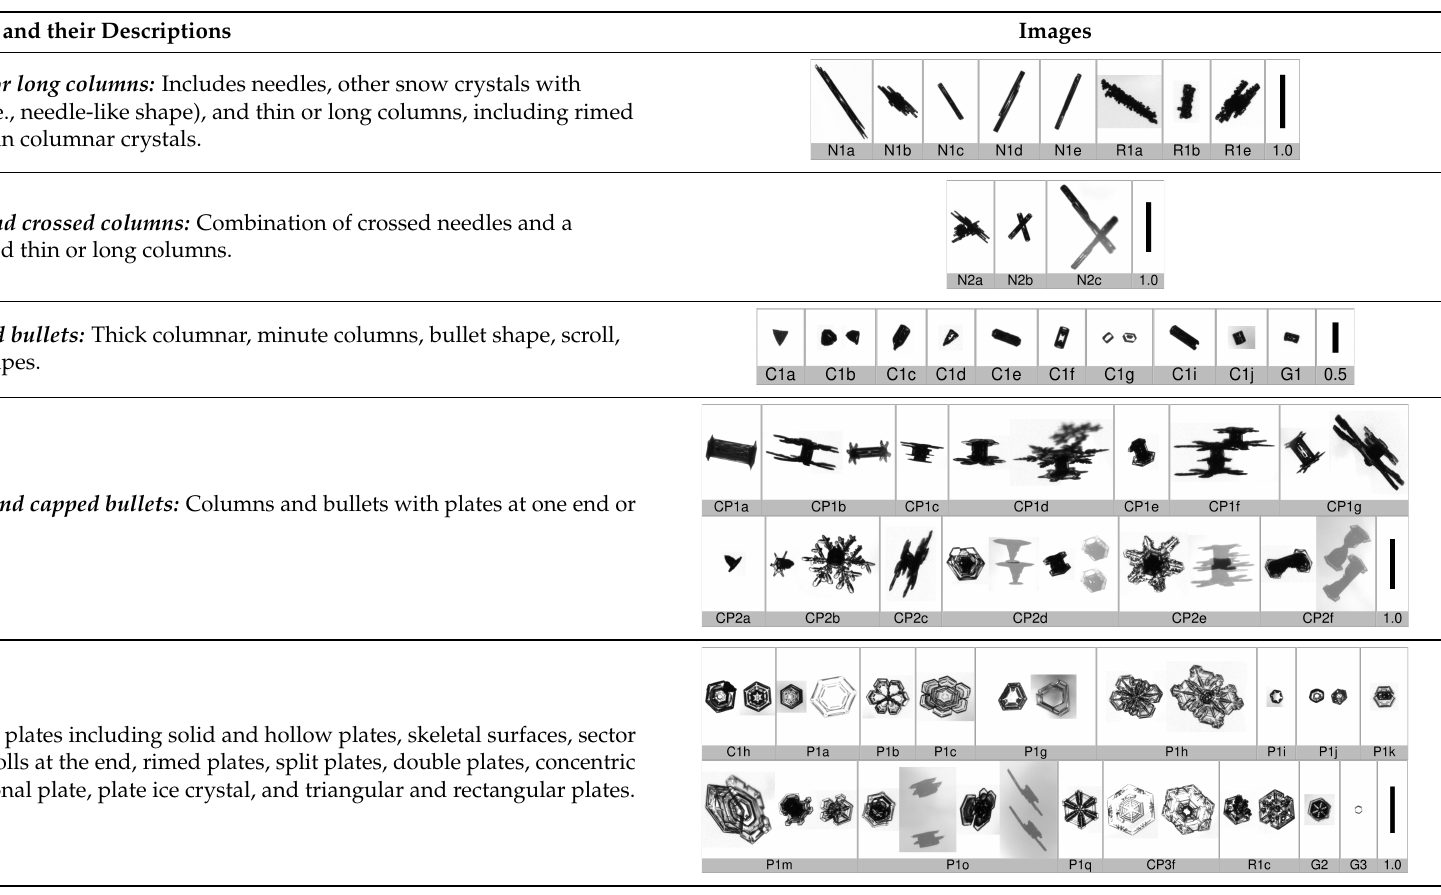
Table 4. Shape groups and their descriptions (part 1): For each of the 15 groups, images of all included shapes are shown. The complete names of these shapes are shown in Table A2 in Appendix